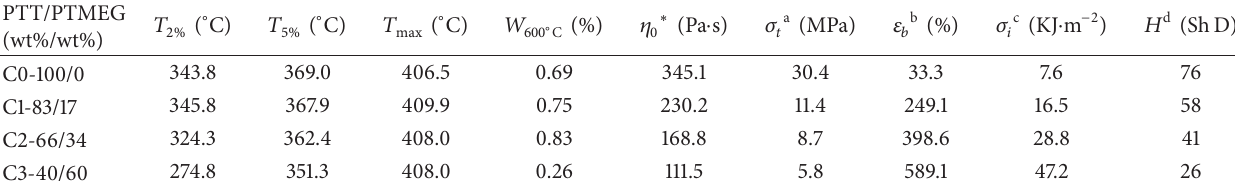
Table 4: Parameters of the TGA curves for the various samples.